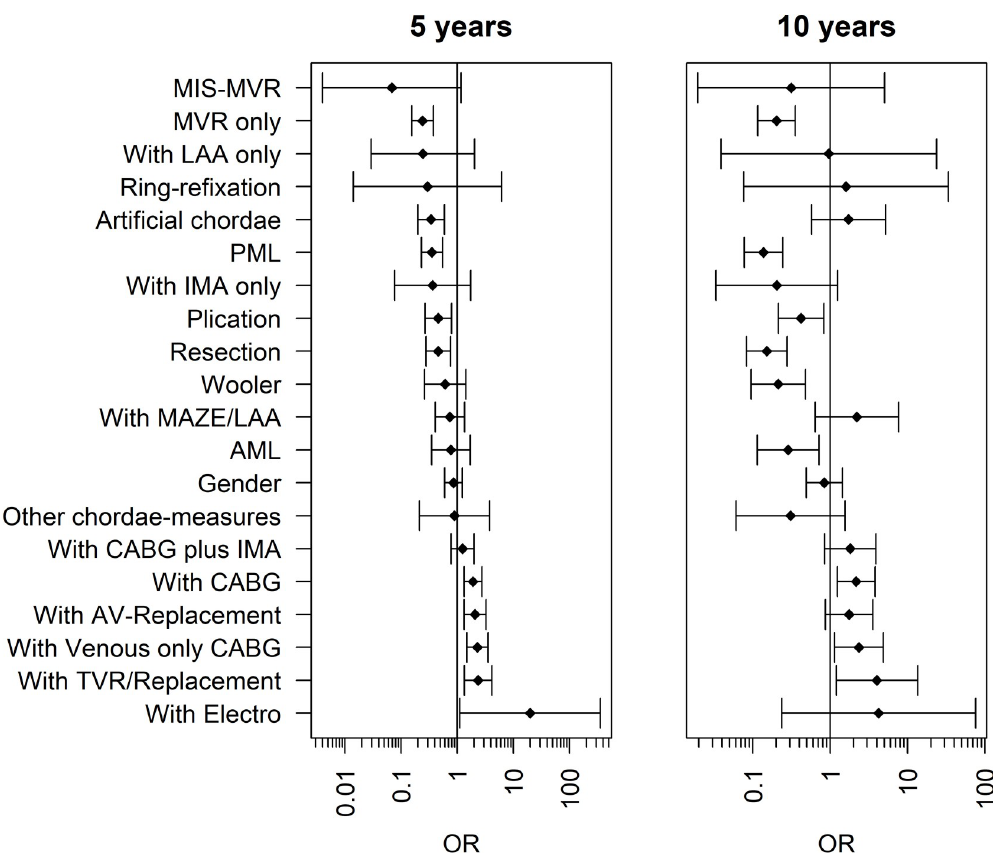
Fig 2. Odds ratios for long-term survival (5- and 10 years). MIC = Minimal invasive; MVR = Mitral valve repair; LAA = Left atrial appendage closure; PML = posterior mitral leaflet; IMA = Internal mammary artery; MAZE = Atrial ablation therapy; AML = Anterior mitral leaflet; CABG = Coronary artery bypass graft; AV-Replacement = Aortic valve replacement; TVR/Replacement = Tricuspid valve repair or replacement; Electro = Electrophysiological